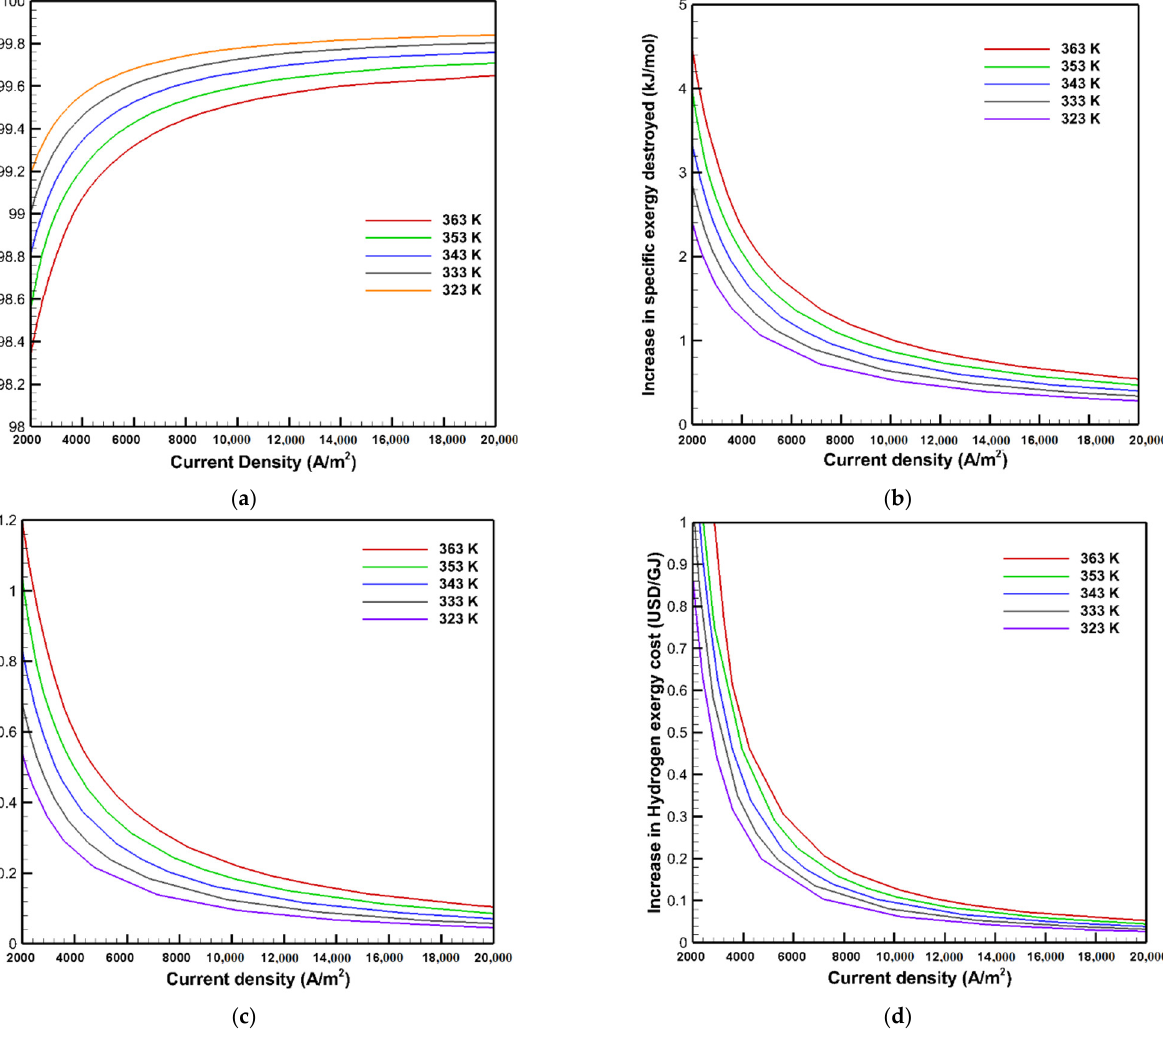
Figure 7. Effects of temperature on: ( a ) Faraday’s efficiency; ( b ) the increase in exergy destroyed; ( c ) the decrease in second law efficiency; and ( d ) the increase in hydrogen exergy cost.